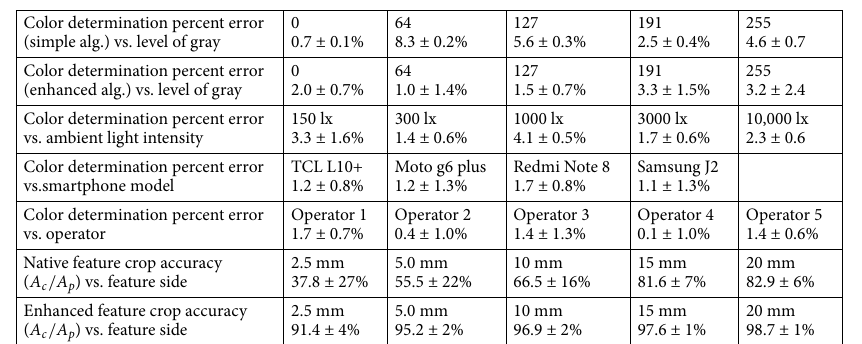
Color determination percent error vs. operator Native feature crop accuracy ( A c / A p ) vs. feature side Enhanced feature crop accuracy ( A c / A p ) vs. feature Table 1. Performance of appuente . Percent error = 100 | g o − g e | / 255 , where g e and g o are the expected and the obtained level of gray, respectively. A c = area of the desired feature effectively captured, A p = real area of the feature. Ranges represent the minimum and maximum values obtained after five runs (n = 5).